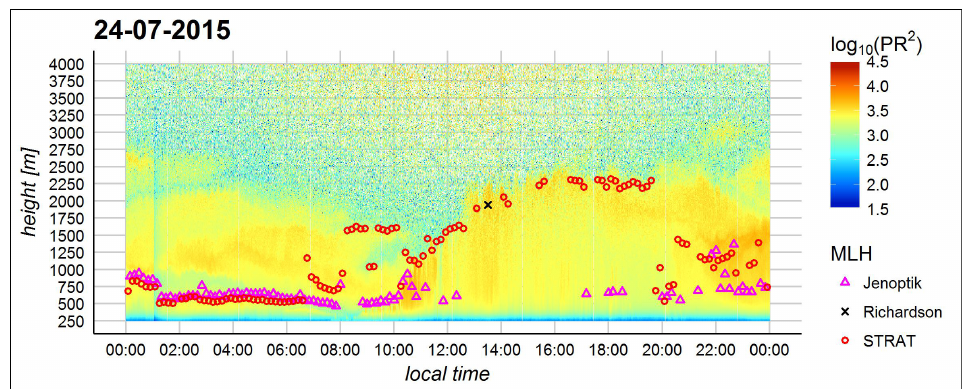
Figure 5. Time-height cross section of the ceilometer’s range-corrected backscatter power (PR 2 in arbitrary units) on 24 July 2015. The MLH retrieved from ceilometer’s data by Jenoptik and STRAT algorithms are marked by magenta triangles and red circles, respectively (for clarity, the Jenoptik MLHs are plotted with the same temporal resolution as STRAT—10 min). Radiosonde-based MLH according to the Ri method is presented by black ”x”